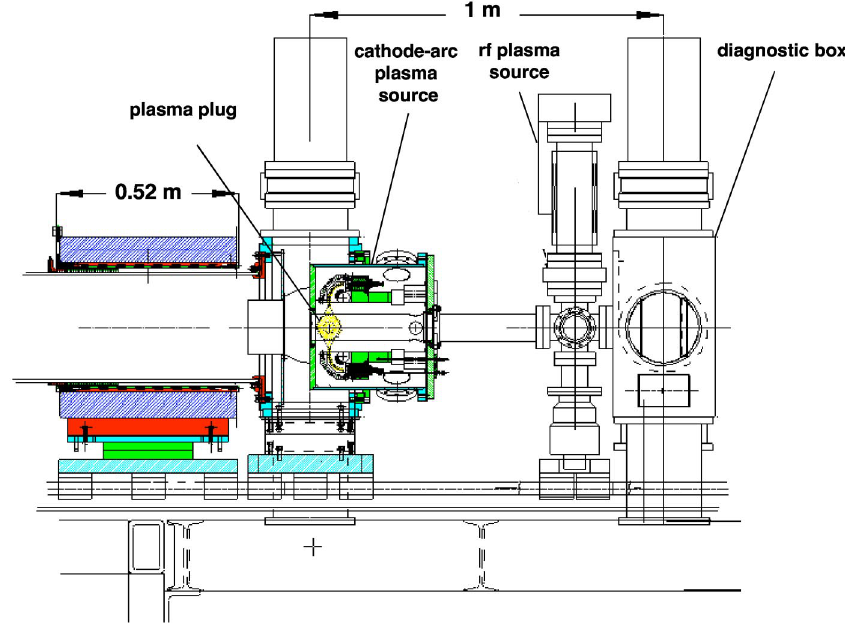
FIG. 3. (Color) Plan view of the NTX neutralization